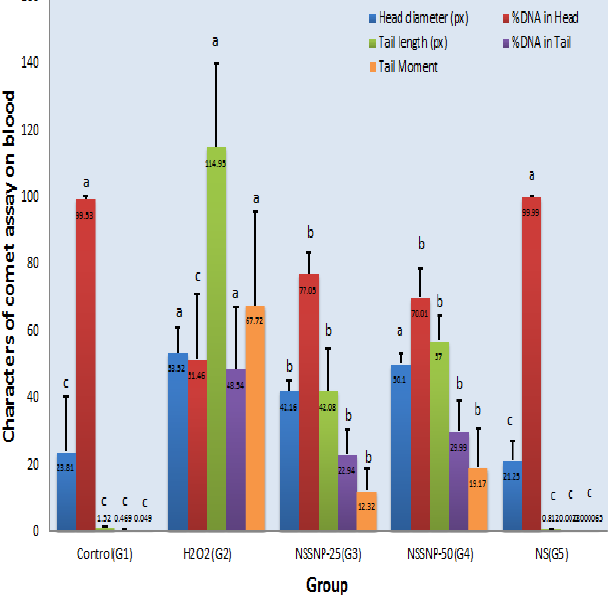
Figure 10. Effect of Nigella sativa seeds silver Nanoparticles by two dose and Nigella sativa extract O exposed 2 2 characters of comet assay on blood in H rats. Values are expressed as mean±SE (n= 8). Various small letters denote significant differences